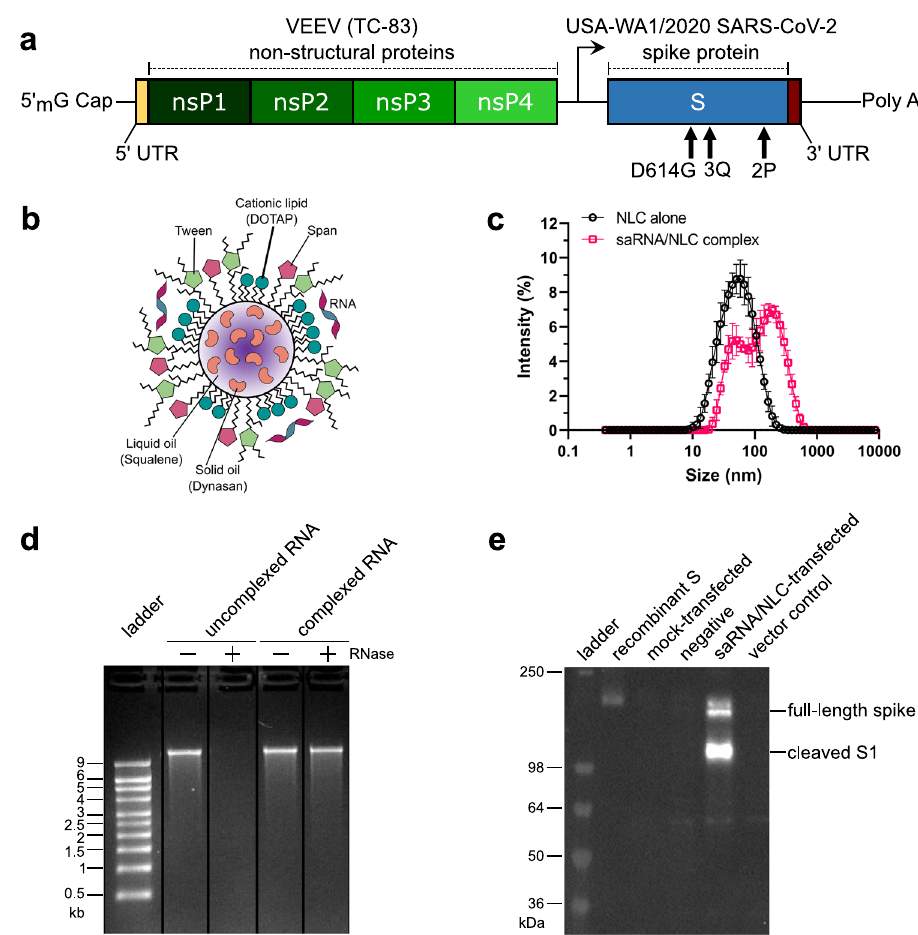
Fig. 1 Design and characterization of SARS-CoV-2 D614G saRNA/NLC vaccine. a SARS-CoV-2 saRNA vaccine schematic. b RNA/ nanostructured lipid carrier (NLC) vaccine formulation. Design by Cassandra Baden. c Size distribution of NLC formulation particles alone (black) and saRNA/NLC complex (pink) showing mean and standard deviation of n = 3 replicate measurements for each sample. d SARS-CoV-2 saRNA complexed to the outside of the NLC particles is full-length intact saRNA that is protected by the NLC complexation from RNase degradation. Lanes were derived from the same gel and re-arranged (see Supplementary Fig. 7). e Western blot showing SARS-CoV-2 spike (S) protein expression in saRNA/NLC vaccine-transfected HEK-293 cells. Blot was derived from the same experiment and processed in parallel. See Supplementary Fig. 7 for the original unprocessed blot